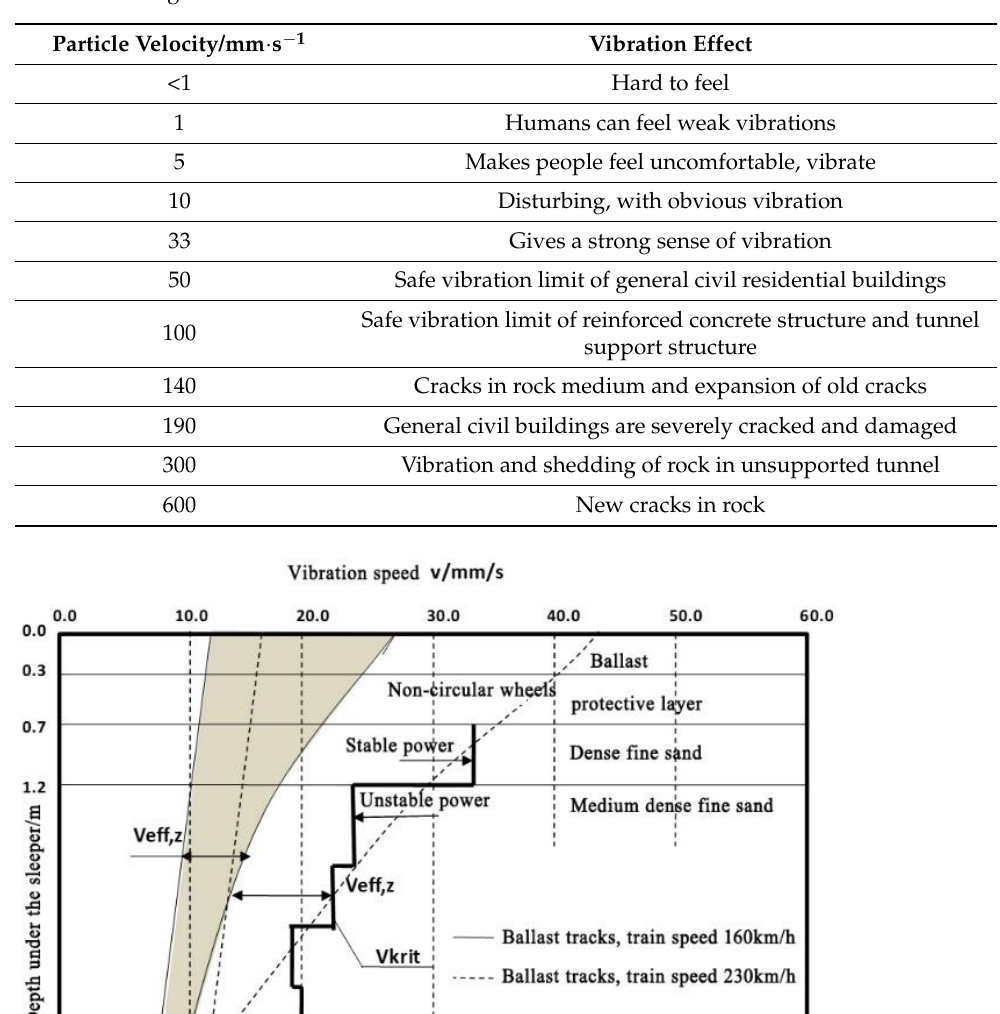
Figure 11. Testing vibration velocity curve. ( a ) is Speed 60 km/h; ( b ) is Speed 120 km/h. Table 3. Blasting vibration effect.